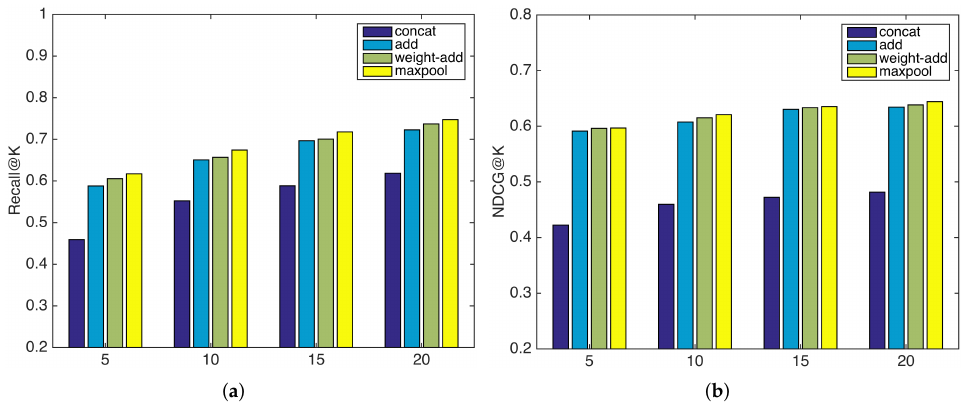
Figure 4. Impact of different fusion strategies. ( a ) Recall@K; ( b )